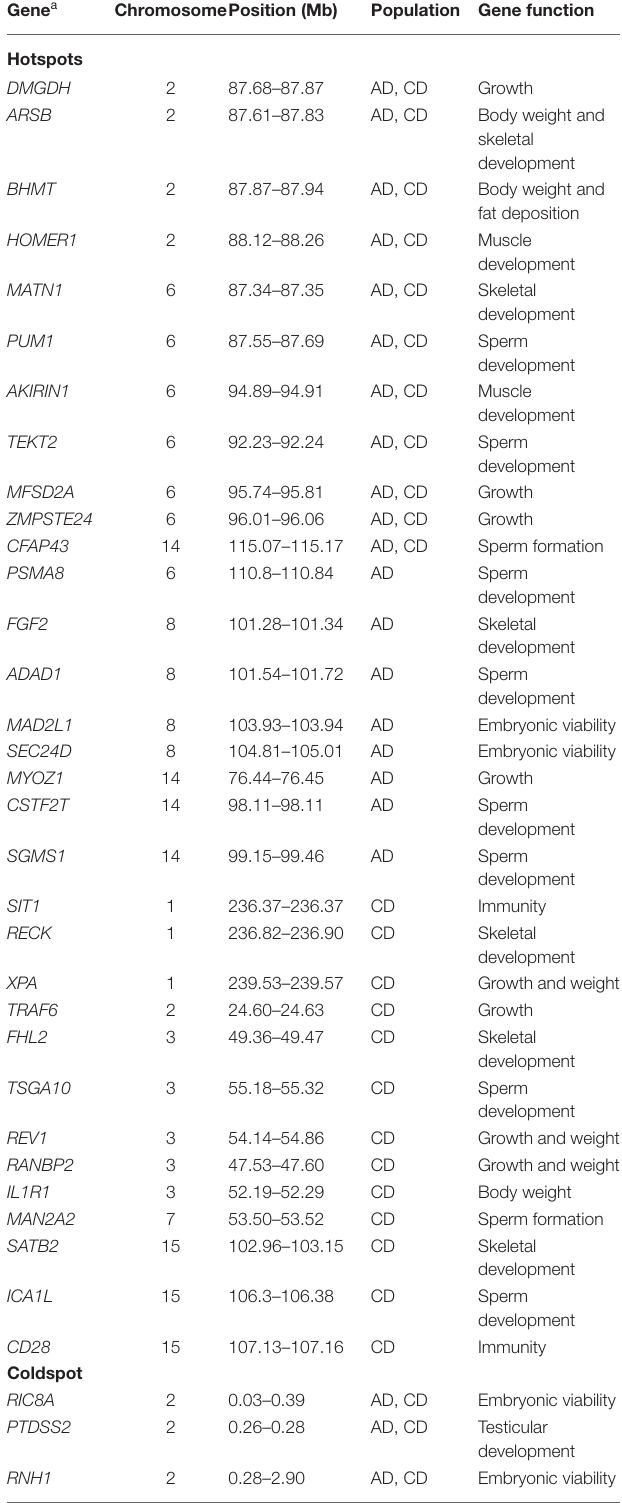
TABLE 3 | Some candidate genes related to phenotypic traits in ROH hotspots and coldspot. Gene